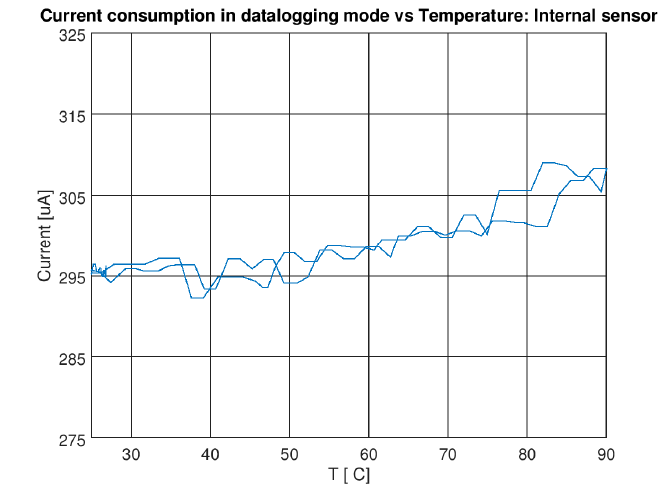
Figure 6. Effects of the temperature over current consumption in data logging